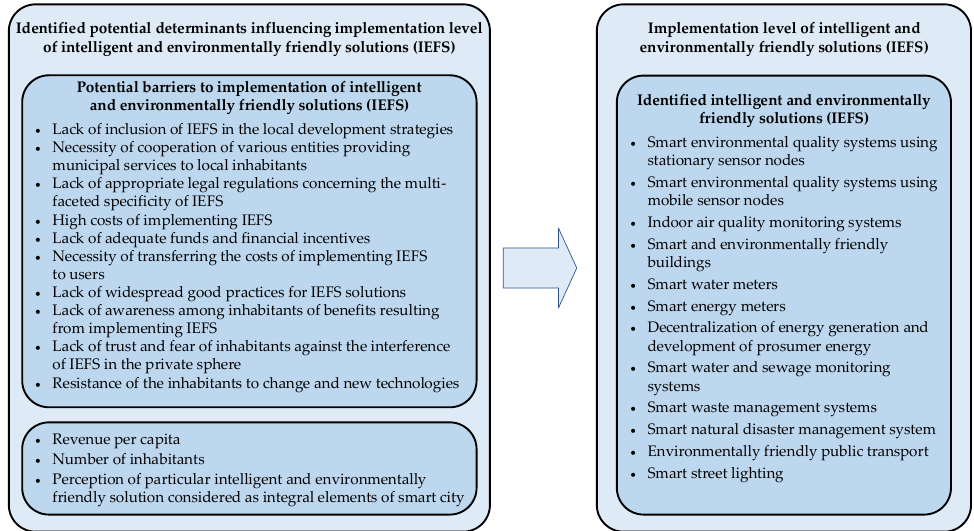
Figure 1. An overview of the literature review results.